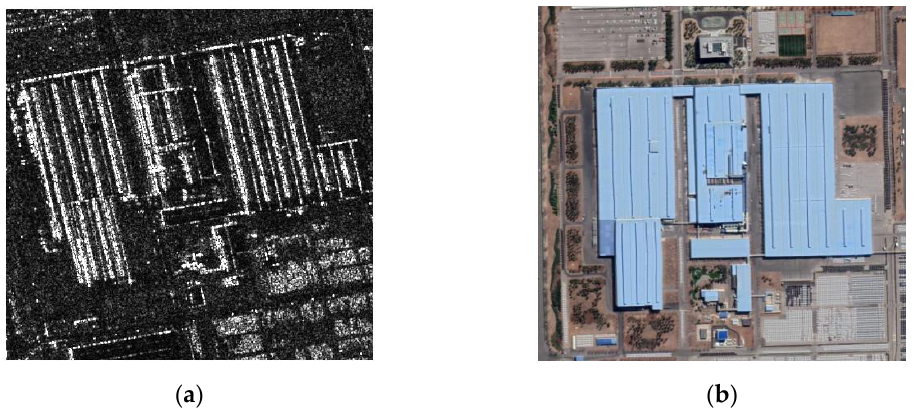
Figure 14. The selected area in TerraSAR-X image and Google Earth. The selected building is a large single building in the city. ( a ) TerraSAR-X image. ( b ) Google Earth.